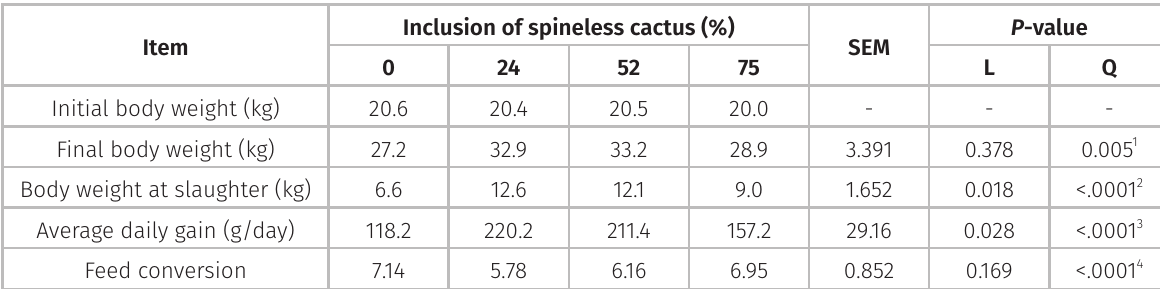
Table V. Performance of lambs fed with increasing levels of spineless cactus inclusion in the diet.